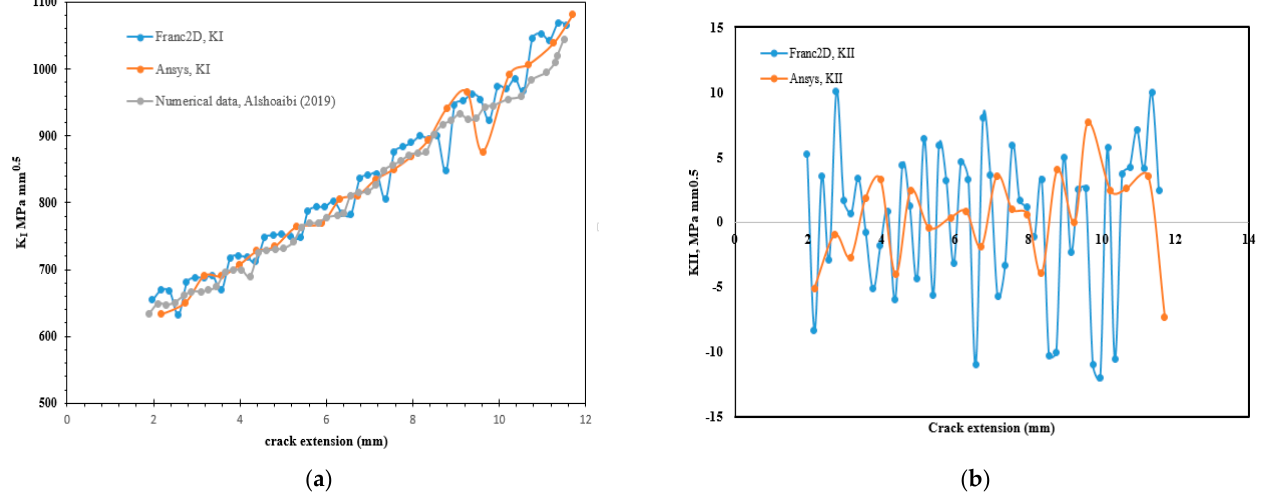
Figure 5. Stress intensity factors with corresponding crack length for specimen G1, ( a ) K I , and ( b ) K II .